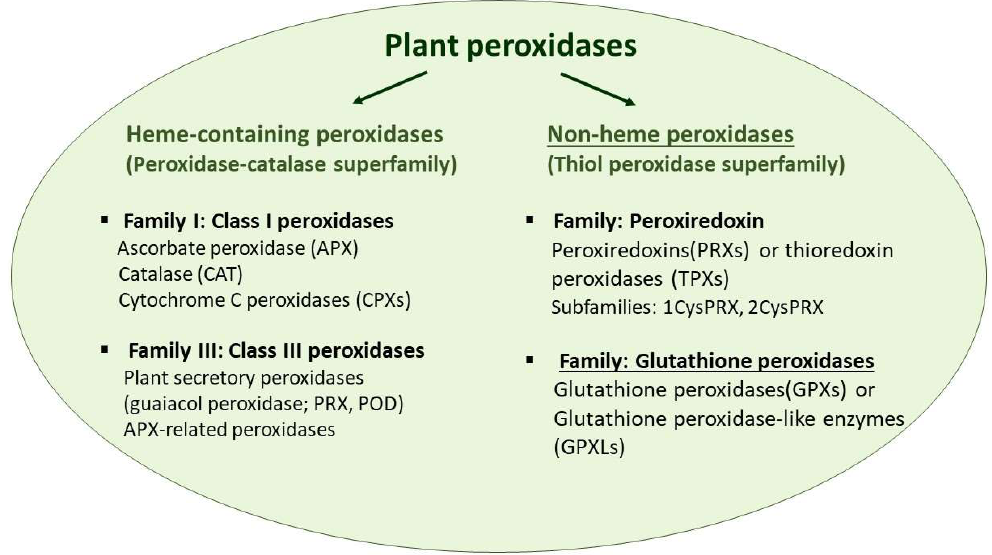
Figure 1. Schematic representation of classification of plant peroxidases using information from the RedoxiBase database (https://peroxibase.toulouse.inra.fr, accessed on 22 June 2022) and in [3,10]. GPXs (EC 1.11.1.9 for classical glutathione peroxidase and EC 1.11.1.12, phospho- lipid-hydroperoxide glutathione peroxidase) differ substantially both for the oxidizing peroxides and the reducing substrates [11]. They catalyze the reduction of H 2 O 2 or organic hydroperoxides to water or corresponding alcohols and oxidize reduced glutathione (GSH, γ-Glu-Cys-Gly) or thioredoxin (TRX) [12,13]. The first GPX was discovered in erythrocytes [14], but later several GPXs were described in all estimated eukaryotic or- ganisms. Some of the GPX isoenzymes contain the highly reactive selenocysteine (SeCys) residue in their active site, while others contain Cys [15]. Both the seleno- or nonseleno GPXs are considered to be central components of ROS-processing mechanisms in animals [13,16]. Mammals harbour eight GPX isoenzymes (GPX1-8), of which five (GPX1-4 and GPX6 in human) contain SeCys in their active site, and three (GPX5, GPX7, and GPX8) such as fertility, anti-inflammatory and anti-carcinogenesis associated routes [18,20,21]. It was suggested that the convergent expansion of mammalian GPXs in independent line- ages might be important for avoiding oxidative damages and the adaption to stressful environments [22]. GPX4, otherwise called phospholipid hydroperoxide glutathione pe- roxidase (PHGPX) and originally peroxidation inhibiting protein (PIP), participates